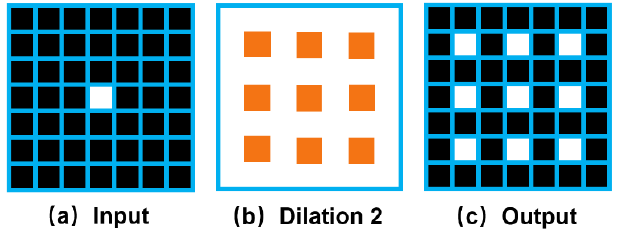
Figure 4. The gridding artifacts are caused by dilated convolution. ( a ) represents the input of a point pixel. ( b ) represents a layer of dilated convolution. ( c ) represents the output after dilated convolution. A single point pixel is mapped into multiple.